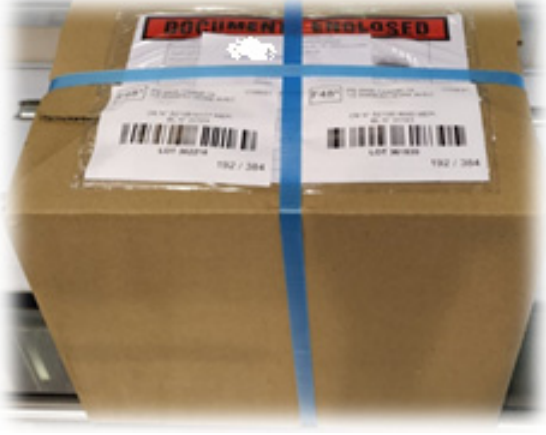
Figure 9. Final packaging. Figure 10 represents a flowchart of the respective production cycle described above.